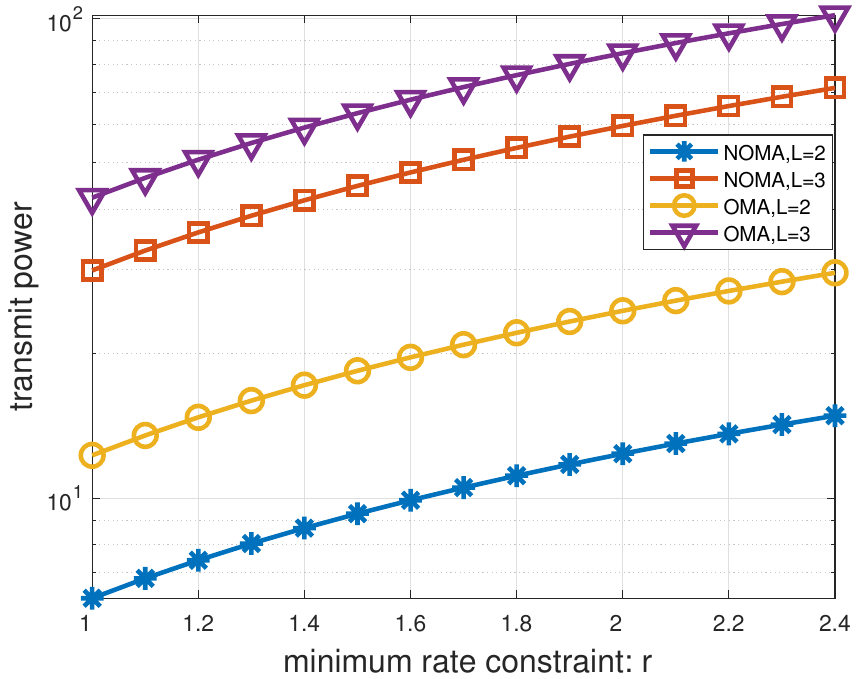
Figure 5. Transmit power versus minimum rate constraint r , when γ = 0.02 , ρ =